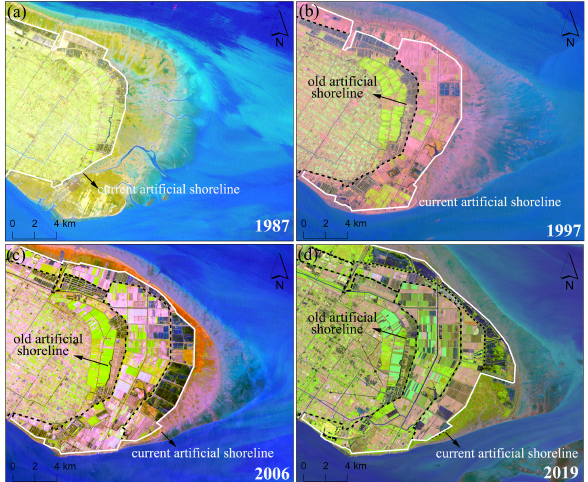
Figure 6. Building a new shoreline on the continuously accretionary tidal flats on the east shoal of Chongming Island, Yangtze